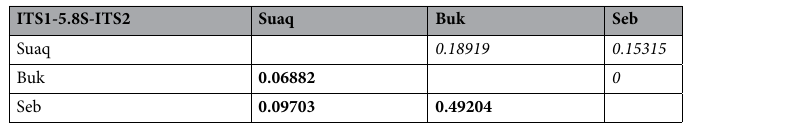
Table 3. Estimates of genetic differentiation (F ST ) obtained between pairs of populations (in bold) and p-value of the test of differentiation (in italics) for ITS1-5.8S-ITS2 gene.